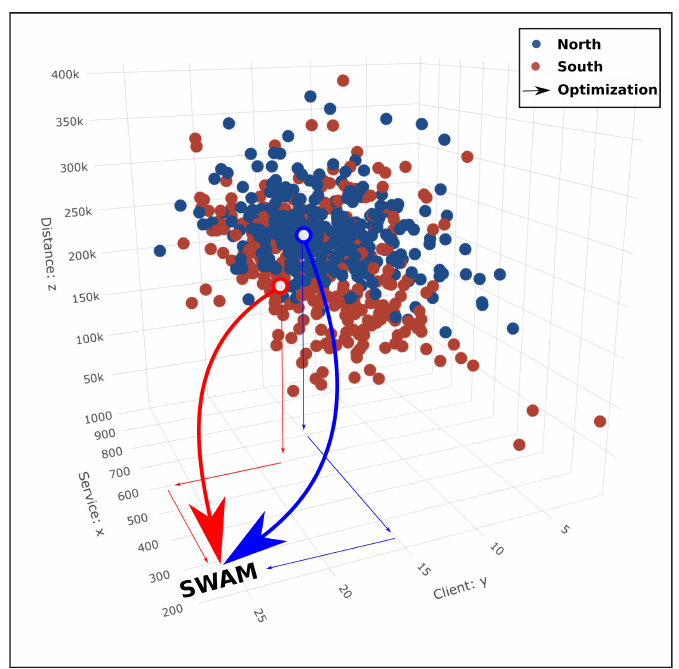
Figure 24. Dispersion plot (Distance, Client, Service time) for each tour (North and